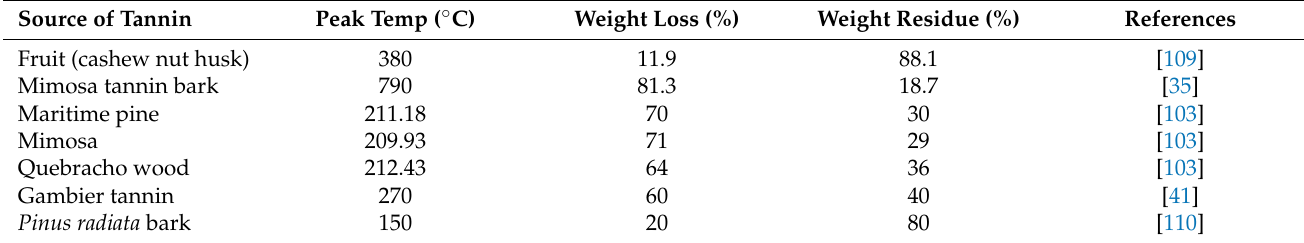
Table 5. Thermal stability of bio-PU resins from different sources of